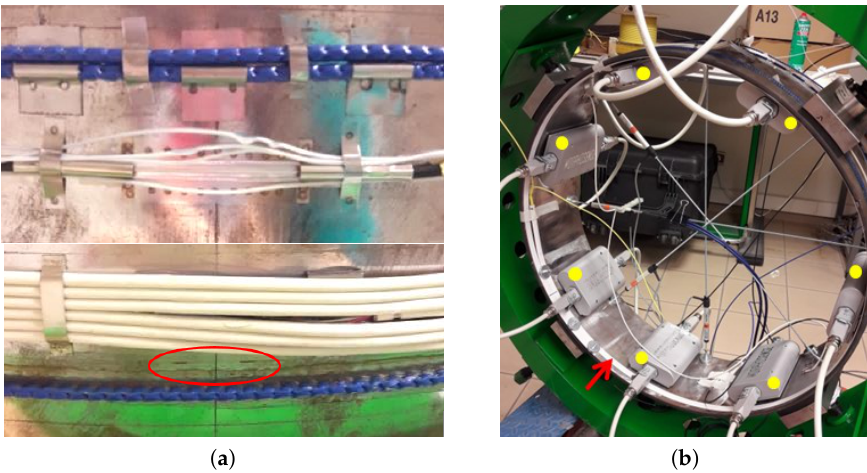
Figure 5. Test mock-up: positions of sensors. ( a ) From top to bottom: soldered cable, soldered FBG, electrical cables for resistive sensors alimentation, glued FBG (circled in red) and glued cable. ( b ) Sensuron sensing cable (red arrow) and Morphosense sensors (yellow points).